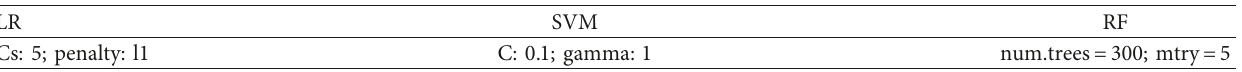
Table 6: For replying interactions from March 12 until April 12 in 2021, utilizing the obtained similarities between nodes, best hyperparameters for LR, SVM, and RF models.